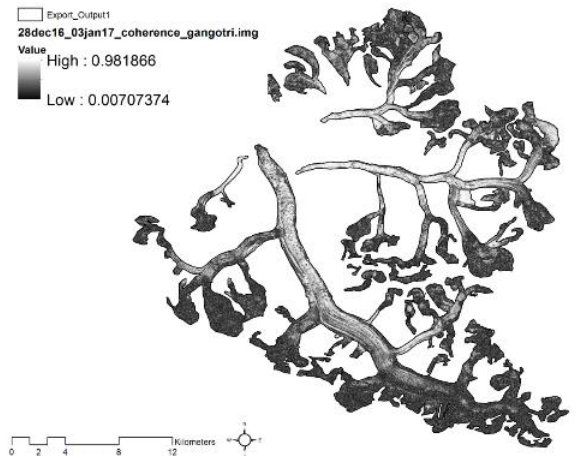
Figure 10: Coherence map of Gangotri glacier